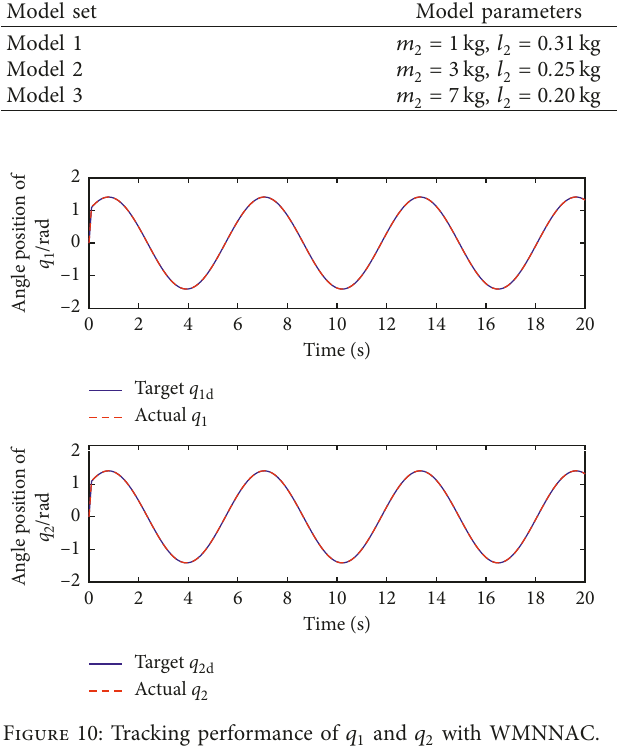
and q with WMNNAC. 1 2